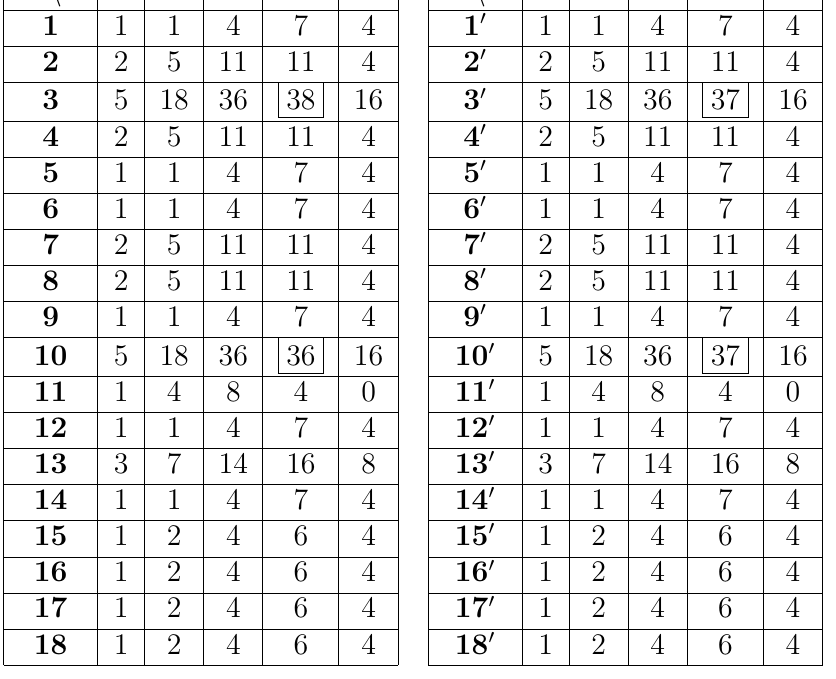
), 𝑉 𝑃 ( 𝑇 ) of the smallest Slater pair in Figure 1 2